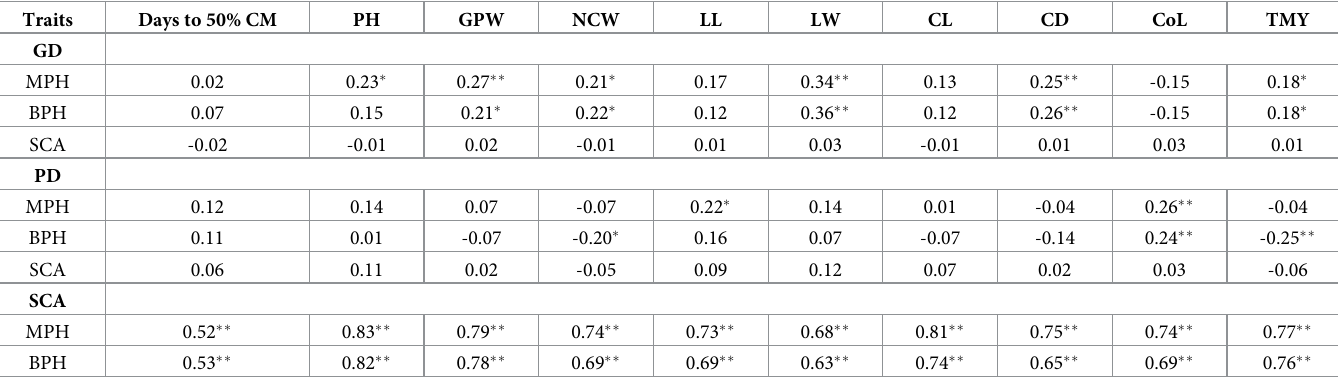
Table 7. Pearson correlation coefficients among parental genetic distance (GD, PD), combining ability and heterosis in cauliflower for ten morphological and com- mercial traits.